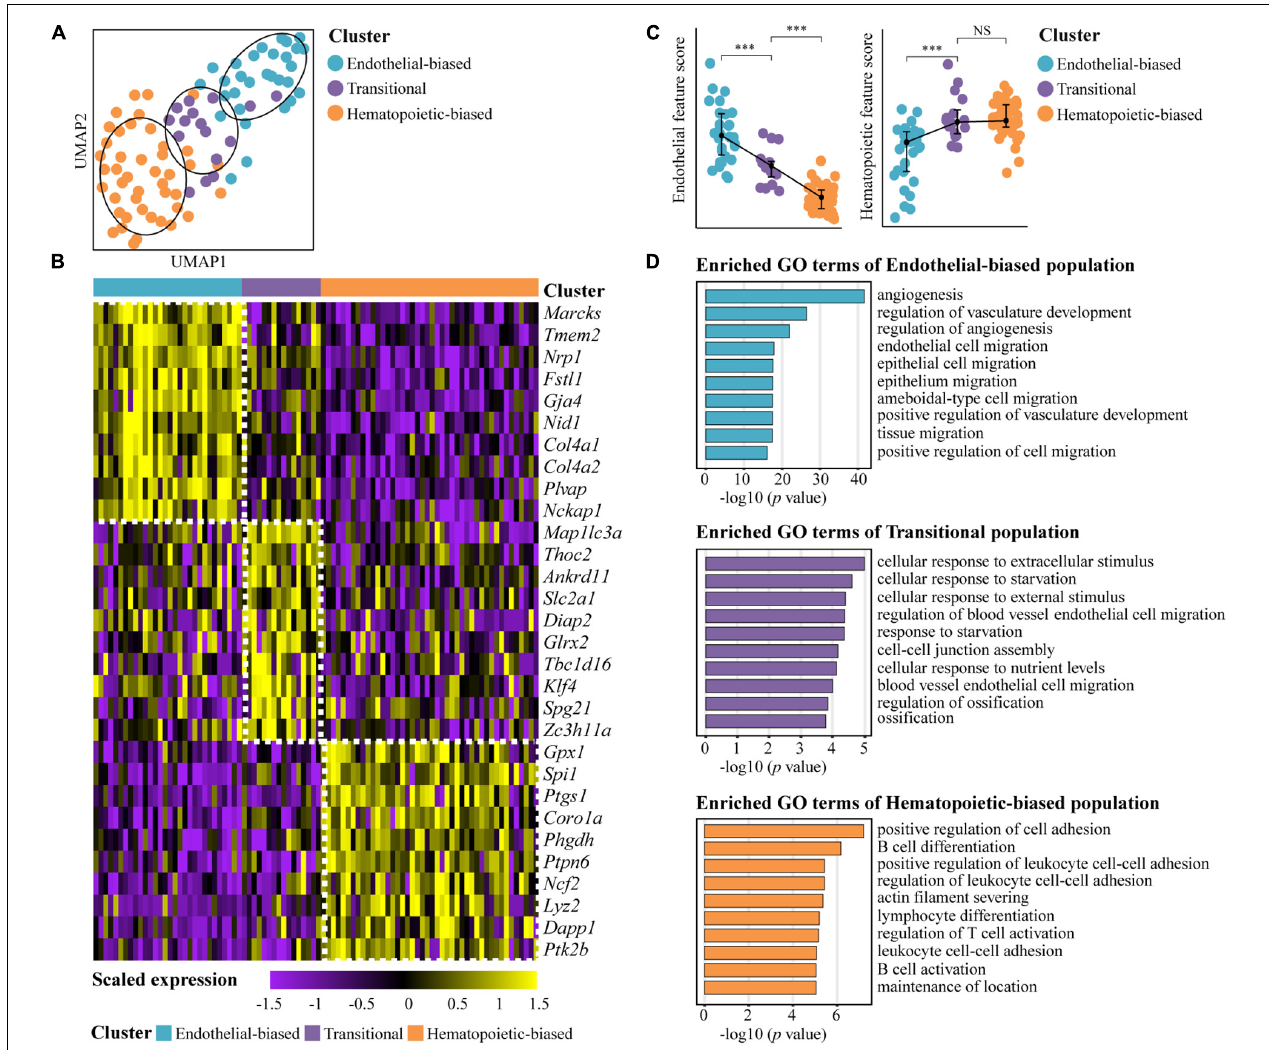
FIGURE 1 | Transcriptomically different subpopulations in E10.0 AGM PK44 cells. (A) UMAP plots of the E10.0 AGM PK44 cells with clusters mapped onto it. (B) Heatmap showing top 10 DEGs of three subpopulations (endothelial-biased, transitional, and hematopoietic-biased population) in E10.0 AGM PK44 cells. DEGs were sorted by ROC power calculated through FindallMarkers function (test.use = “roc”) in Seurat2. (C) Dot plot showing the endothelial and hematopoietic scores of E10.0 AGM PK44 cells in three subpopulations to, respectively, represent the endothelial and hematopoietic characteristics molecularly. The statistical significance of differences was determined using Wilcox test. ∗∗∗ P < 0.001. (D) Enriched GO terms of three subpopulations in E10.0 AGM PK44 cells and top 10 terms with P value < 0.05 are